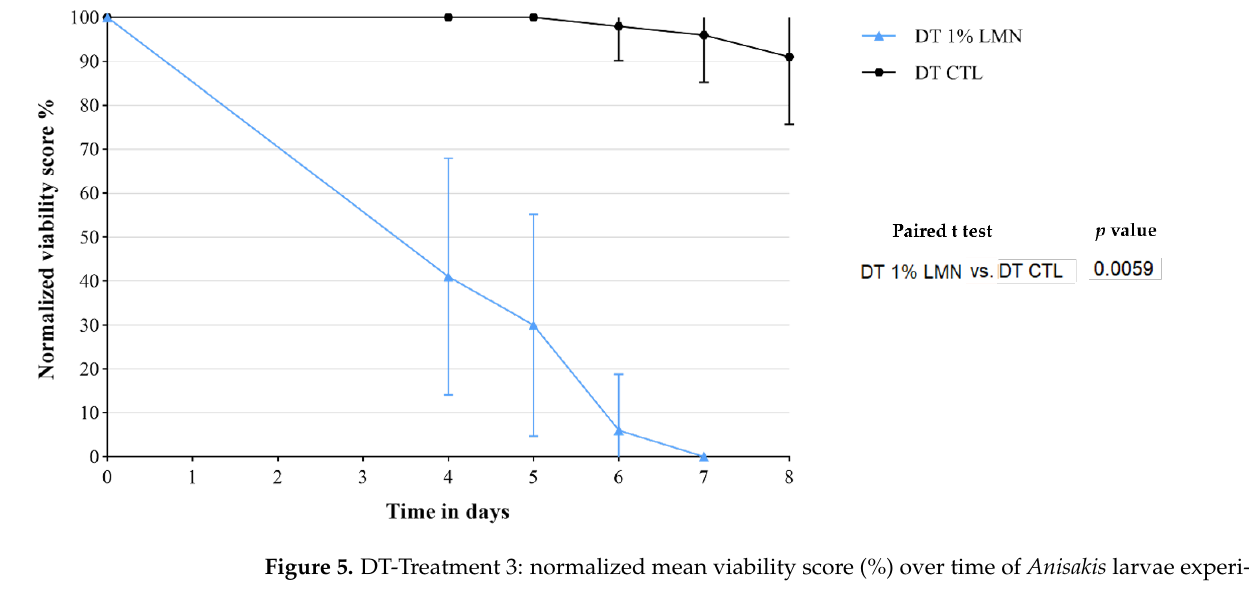
Figure 5. DT-Treatment 3: normalized mean viability score (%) over time of Anisakis larvae experi- mentally parasitized in anchovy fillets exposed to R (+) limonene (LMN) at 1% in a double treatment (DT) both during the marinating process and subsequent storage in sunflower seed oil. The results of the statistical analysis performed for the different treatments are also reported.